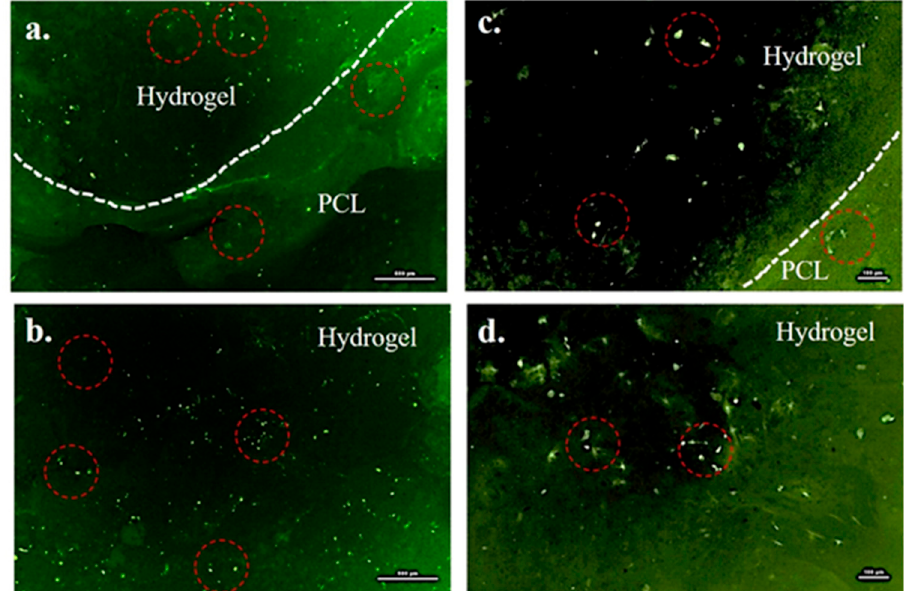
Figure 7. Representative fluorescence images of PCL-gel samples seeded with pre-stained human mesenchymal stem cells showed the presence of cells (green) in the hydrogel ( a , b ) as well as on the PCL struts ( a ). The white-colored broken line shows the boundary between the PCL scaffold and hydrogel. The cells are marked with red circles within both the hydrogel and scaffold areas. Images ( c , d ) are the magnified images of micrographs ( a , b ), respectively. Scale bar for ( a , b ) is 500 µm and for ( c , d ) is 100 µm.